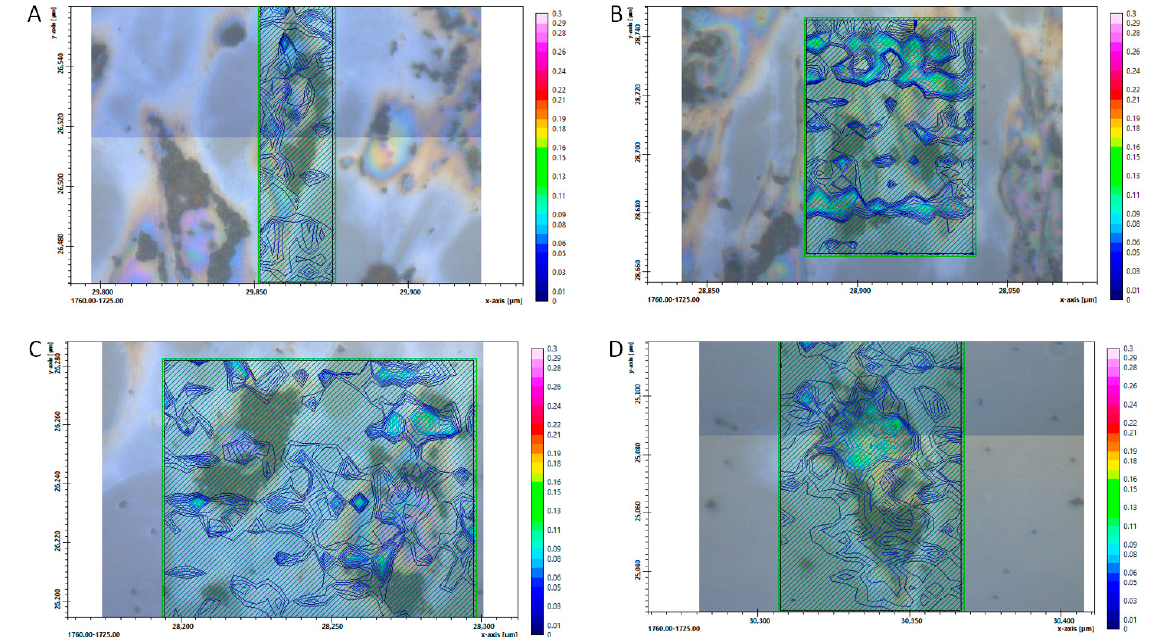
Figure 6. C=O in a single hRPE cell mapping: ( A ) Control, ( B ) H 2 O 2 - ( C ), Rap-, and ( D ) Baf+H 2 O 2 treated cells. The color-coded images of the regions of interest representing C=O are superimposed on the visible light bright field micrographies (field of view). In the cell cytoplasm, pigmentation in the form of melanin pigment granules typical for the primary hRPEs is visible around the clear nucleus.